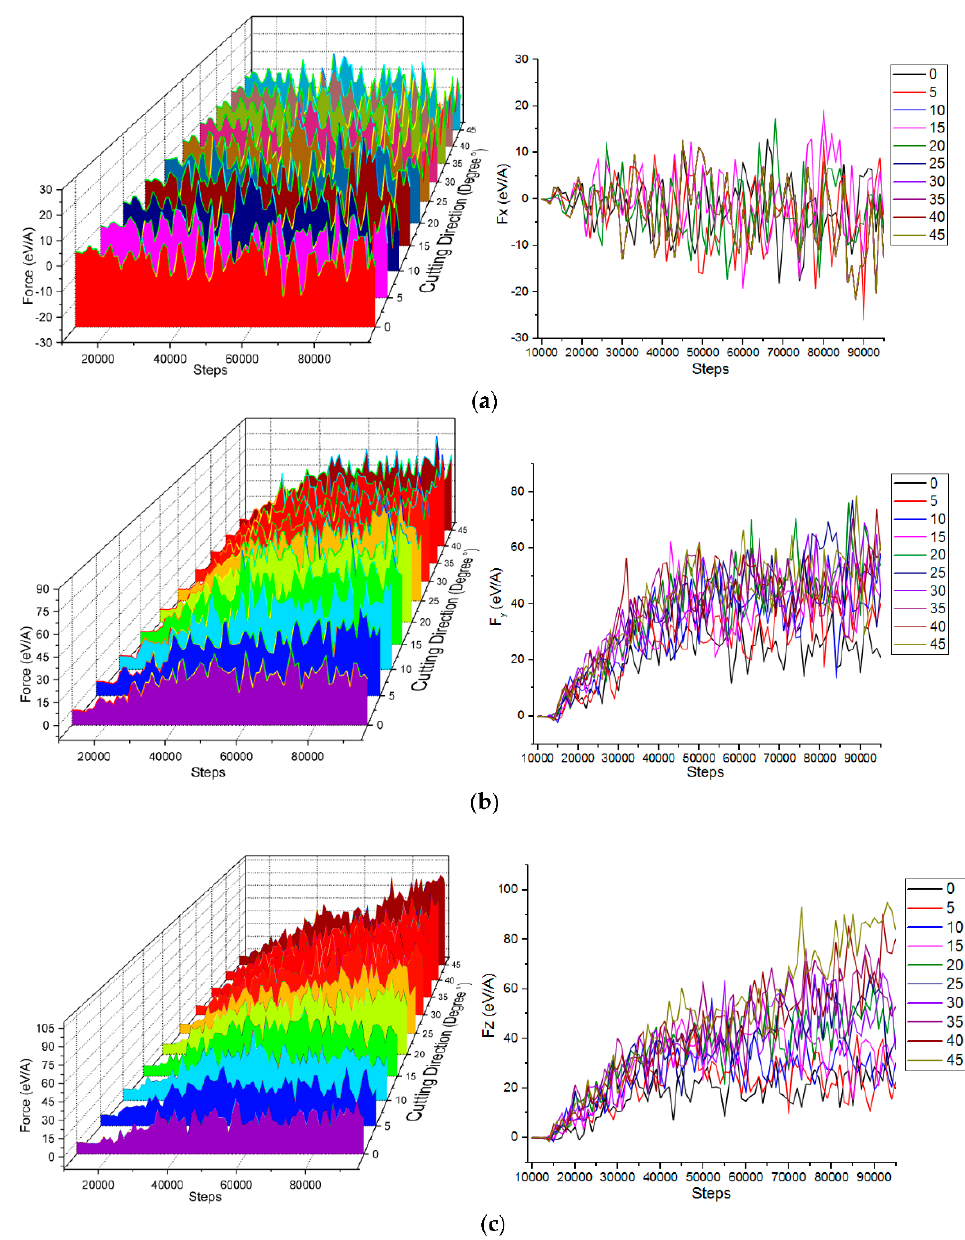
Figure 43. Cutting forces in different directions under various microcutting angles. ( a ) Cutting force in direction of [1¯00]. ( b ) Cutting force in direction of [01¯0]. ( c ) Cutting force in direction of [001] [202].